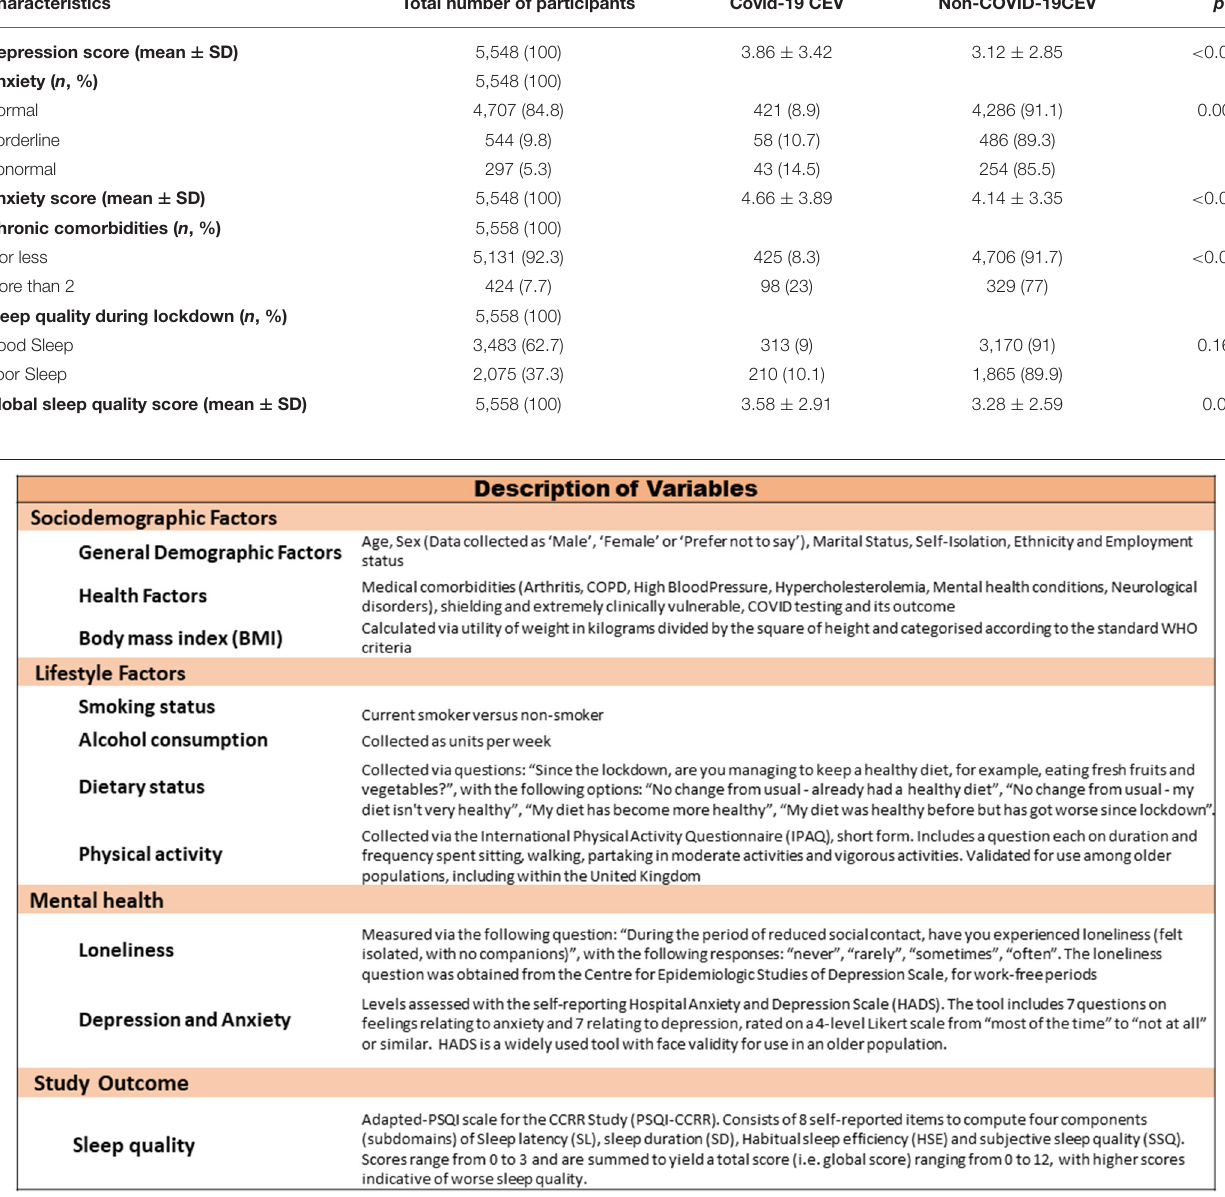
age was 71 ± 7.3 years. During lockdown, the mean ( ± SD) global PSQI-CCRR score was 3.3 ± 2.6, with the 37% participants who scored > 3 categorised as poor sleepers. Most participants were married (68%), not self-isolating (88%) and retired (71%). About 8% of participants had more than two chronic diseases and up to 27% reported feeling lonely often or sometimes ( Supplementary Table 2 ).